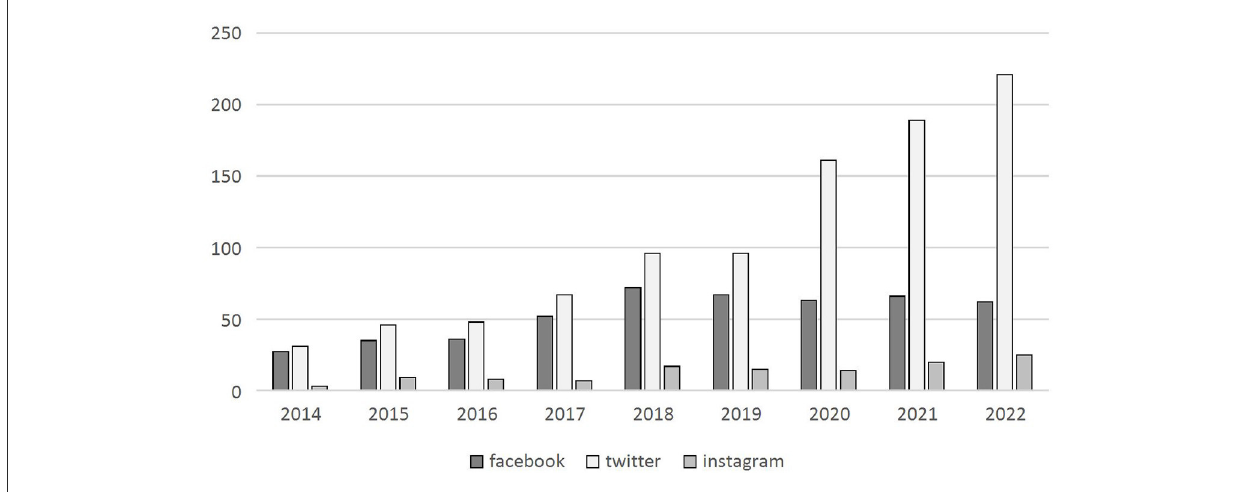
FIGURE1 Publications on data scraping (2014–2022). Elaboration on dimensions